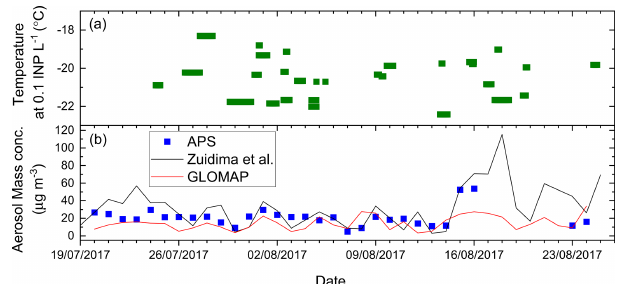
Figure 5. Time series of the temperature at which the INP con- centration was a specified value (0.1INPL − 1 ) in comparison to the aerosol mass concentration derived from the APS (i.e. parti- cles larger than 0.5µm), based on a gravimetric analysis (Zuidema et al., 2019) and predicted by a global aerosol model (GLOMAP) (Vergara-Temprado et al., 2017). The width of the green bars indi- cates the time over which sampling took place.